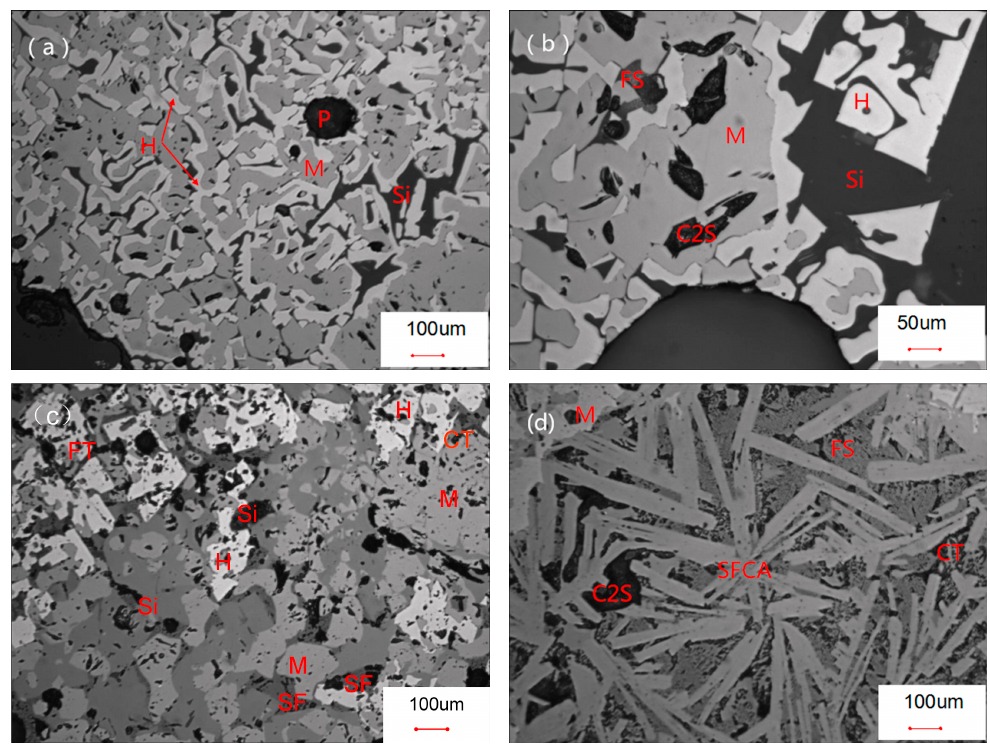
Figure 5. Microstructure images of the PVTM sinter. ( a ) R = 0.33; ( b ) R = 0.5; ( c ) R = 1.1; ( d ) R = 2.6. H: hematite, M: magnetite, Si: silicate, P: pores, C2S: dicalcium silicate, SF: silico-ferrite, SFCA: silico-ferrite of calcium and aluminum, FS: fayalite, CT: perovskite, FT: pseudobrookite.